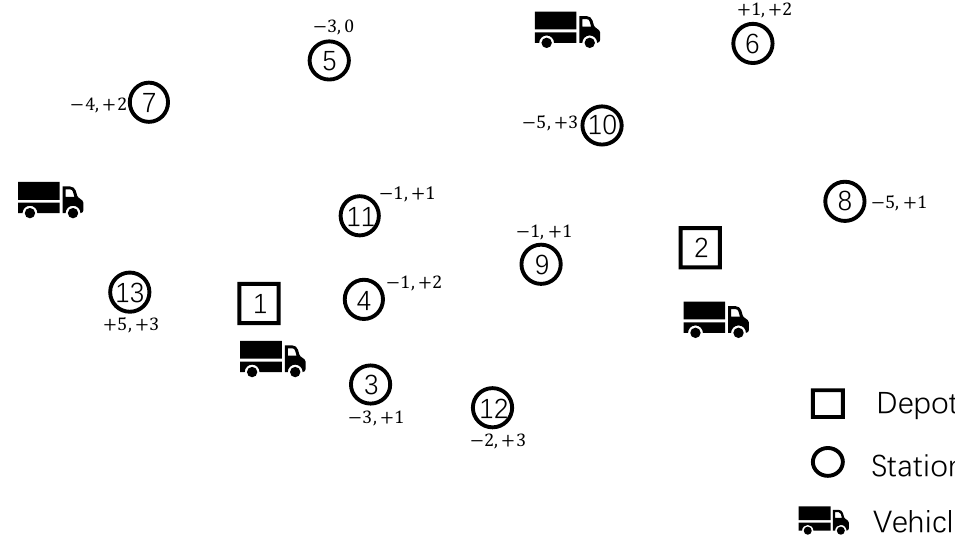
Figure 1. Illustration example of MSBRCP.